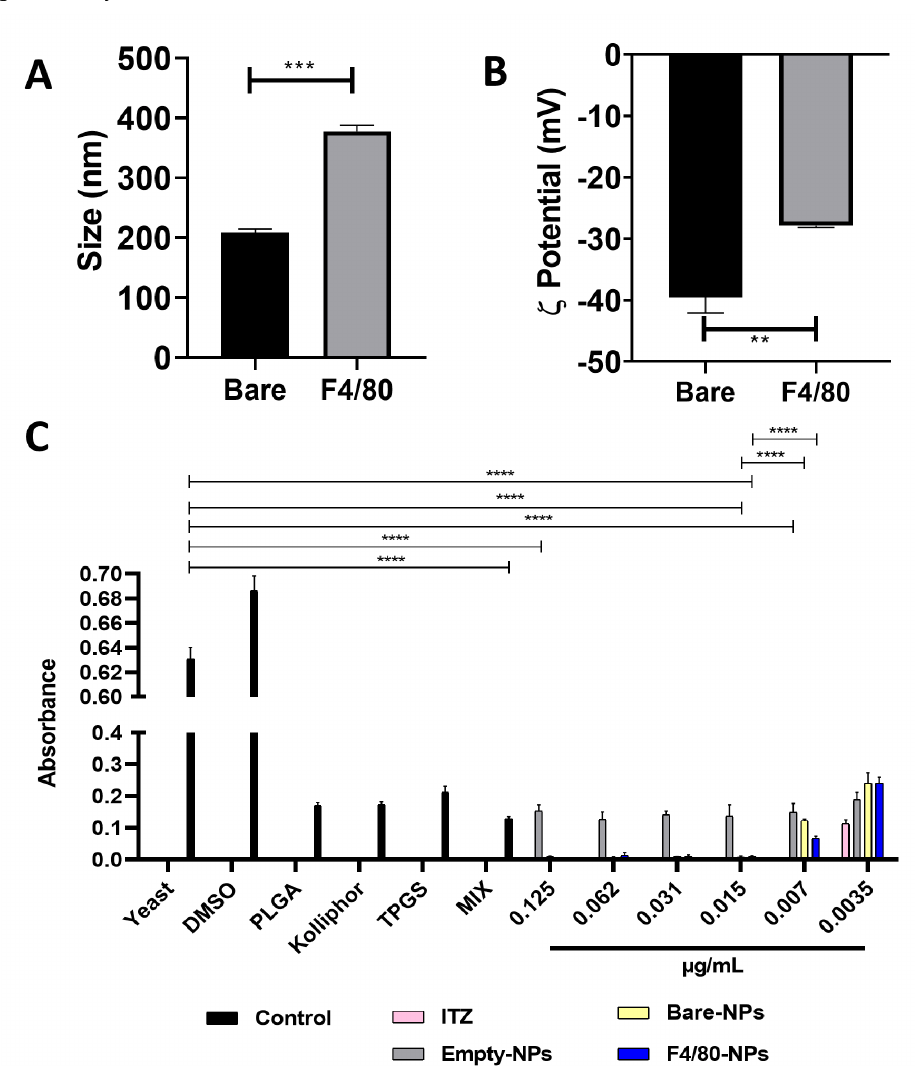
Figure 1. Comparison of size ( A ) and surface charge ( B ) of PLGA75: 25-TPGS-pH5-ITZ NPs functionalized or not (bare) with anti-F4/80 antibodies. ( C ) MIC strain H. capsulatum CIB1980 treated with free-ITZ, ITZ encapsulated into PLGA75:25 TPGS-pH5 NPs functionalized (or not) with anti-F4/80, empty PLGA75:25 TPGS-pH5 NPs and the corresponding amount of each NPs precursor (equivalent to the highest concentration of NPs that were used, i.e., 0.125 µg/mL). **, *** and **** indicate statistically significant differences with p < 0.001, p < 0.0001 and p < 0.00001, respectively.